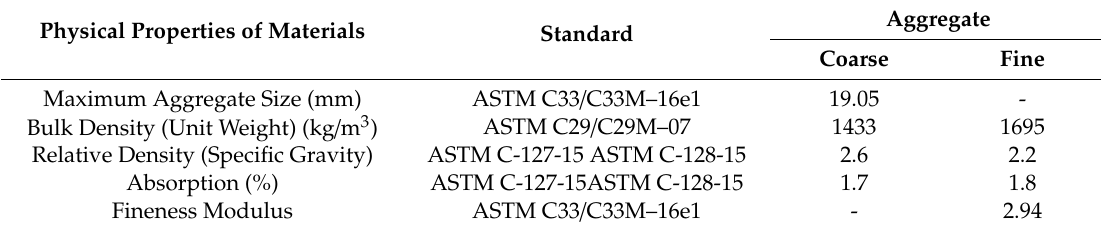
Table 1. Results of the characterization of the aggregates, obtained according to ASTM standards.